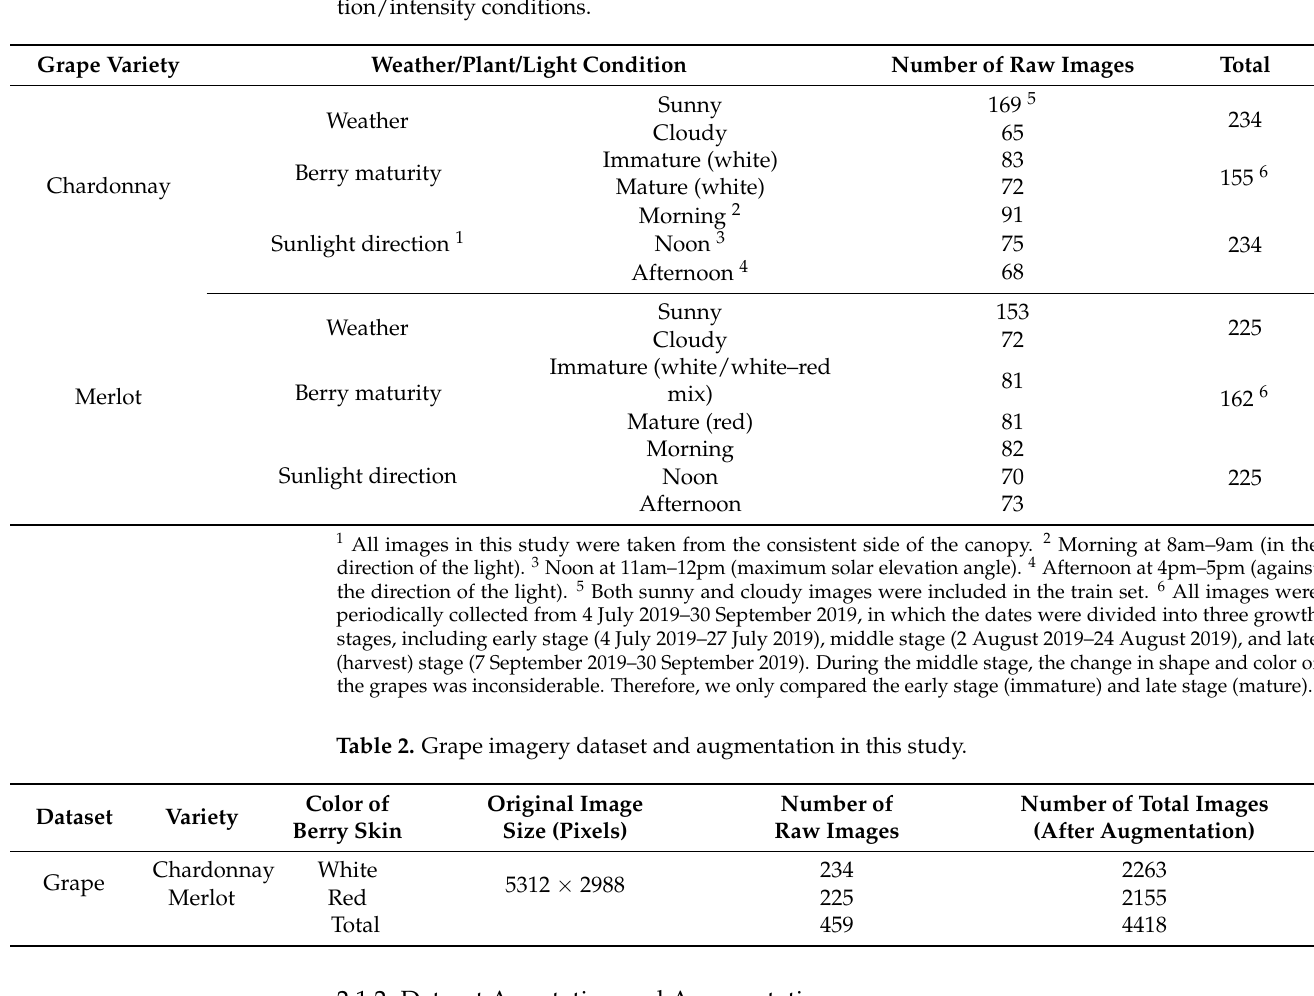
Table 1. Grape dataset collected under different weather, berry maturity, and sunlight direc- tion/intensity conditions.